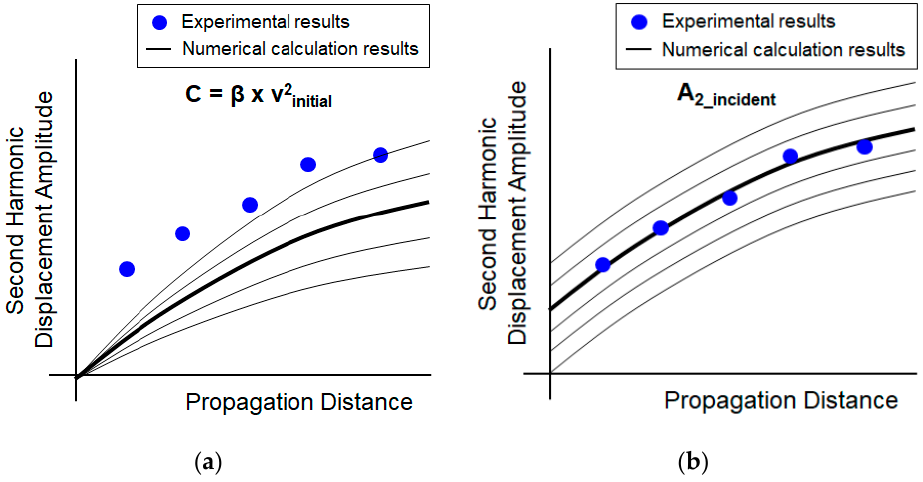
Figure 8. Estimation of second harmonic displacement amplitude ( A 2 ( z ) ) as a function of the propagation distance z calculated using Equation (9), also indicating the relationship to Figure 7d; ( a ) A 2 ( z ) for p 2 ( z ) not equal to 0 in the same p 2 incident